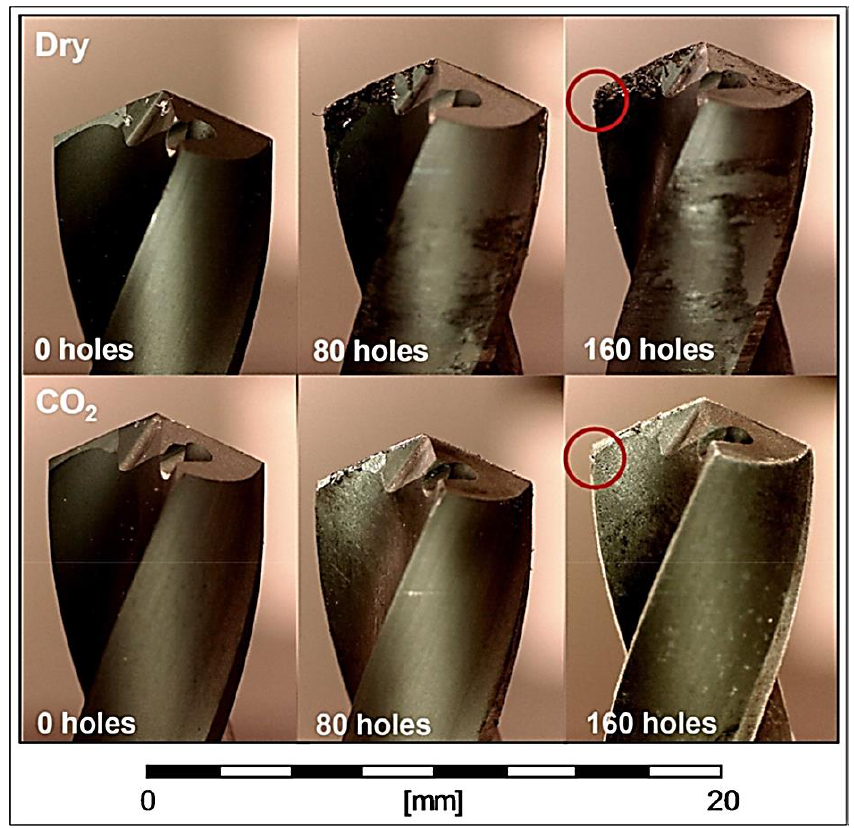
Figure 16. Drilling under dry conditions and with liquified CO 2 ; Red circle indicates the quality of edge surface [132]. Reproduced with permission from Elsevier.